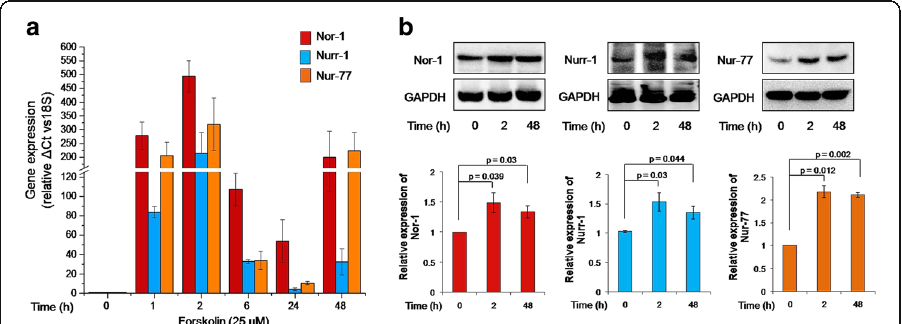
Fig. 1 Expression profile of the members of the NR4A sub-family in BeWo cells treated with forskolin. BeWo cells were treated with forskolin (25 μ M) for various time periods, followed by analysis of NR4A sub-family members at the mRNA and protein levels. a – Transcript profiles of Nor-1, Nurr-1 and Nur-77 in BeWo cells at 0, 1, 2, 6, 24 and 48 h of forskolin treatment. Relative expression was normalized with 18S rRNA. Data are expressed as means ± s.e.m. of three independent experiments performed in triplicate. b – Densitometeric plots of Nor-1, Nurr-1 and Nur-77 using GAPDH as a loading control. Data are represented as means ± s.e.m. of at least three experiments. Representative blots for the same are also shown. p ≤ 0.05 is